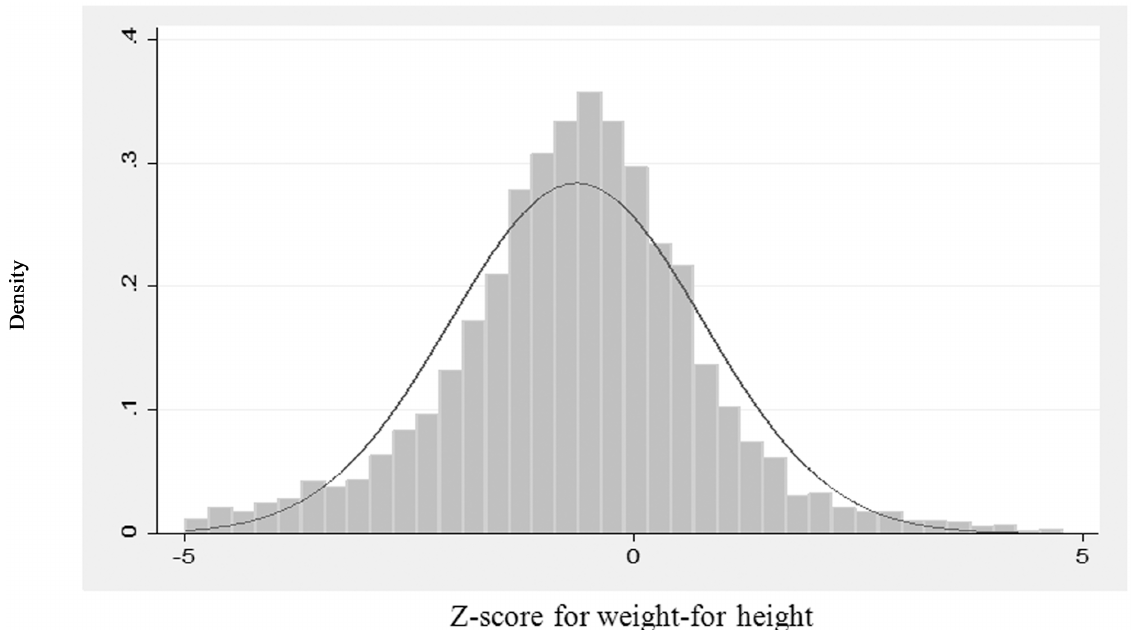
Fig 4. Histogram and normal density plot of z-score of weight-for-height of children in 0 – 59 months in Northeast India. Source: Based on authors computation from National Family Health Survey 3 (NFHS-3), 2005 –